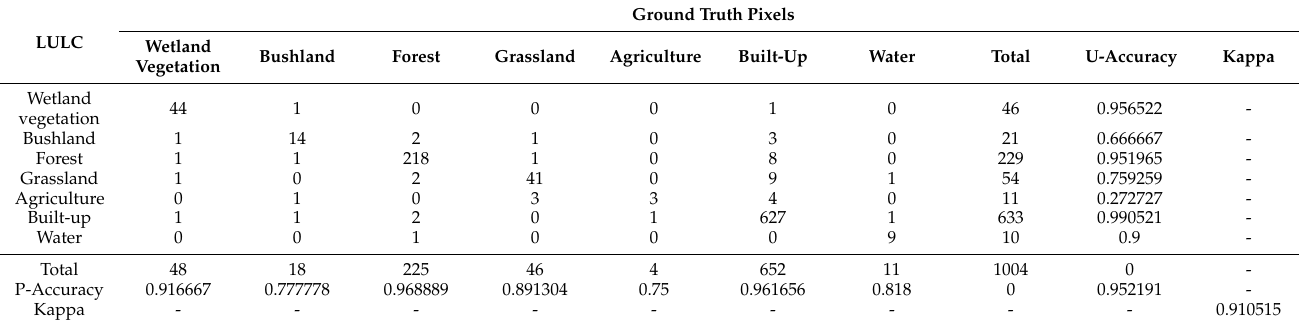
Table 3. Accuracy assessment results of LULC classification for image of 2000.